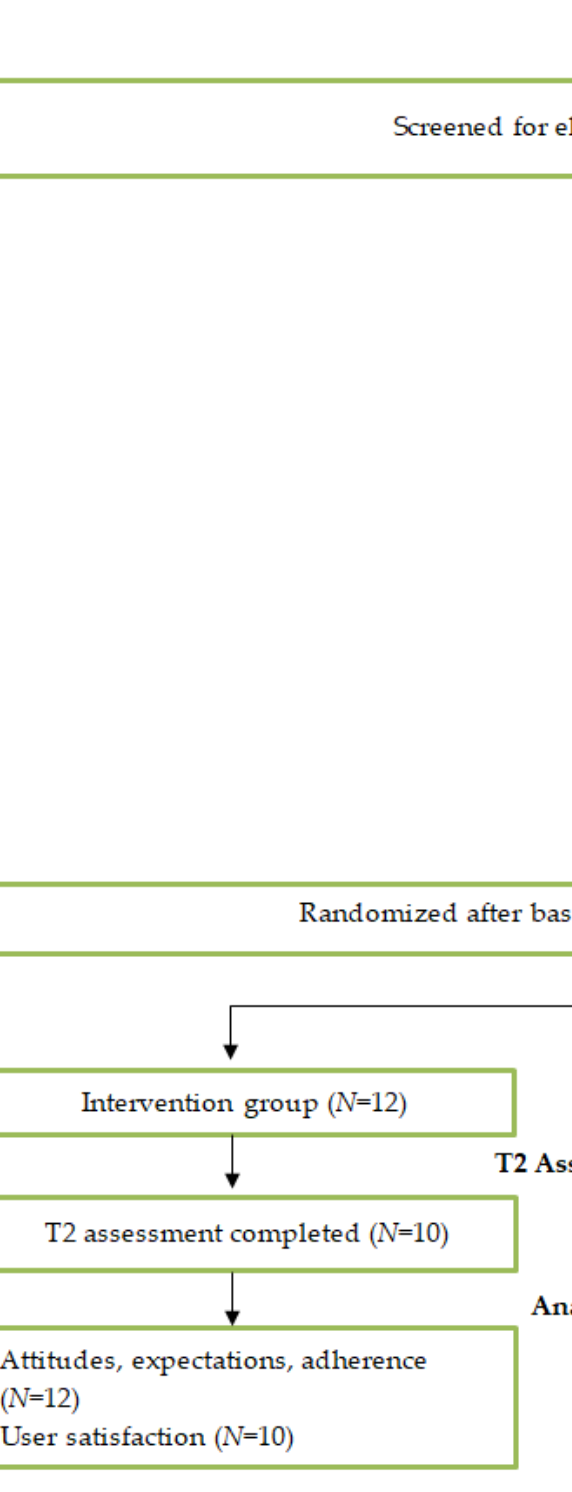
Figure 1. Participant flow.